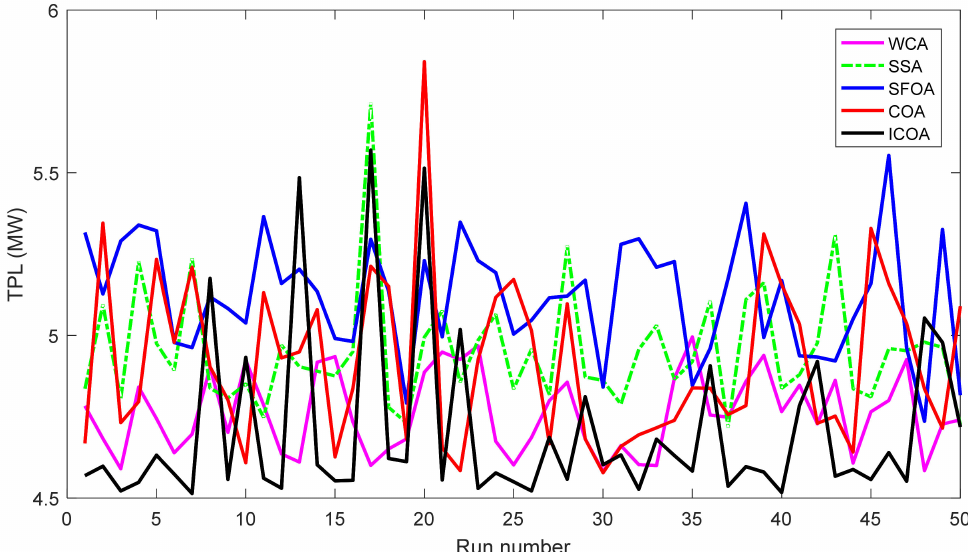
Figure 5. TPL of 50 runs obtained by compared methods for the IEEE 30-bus system.